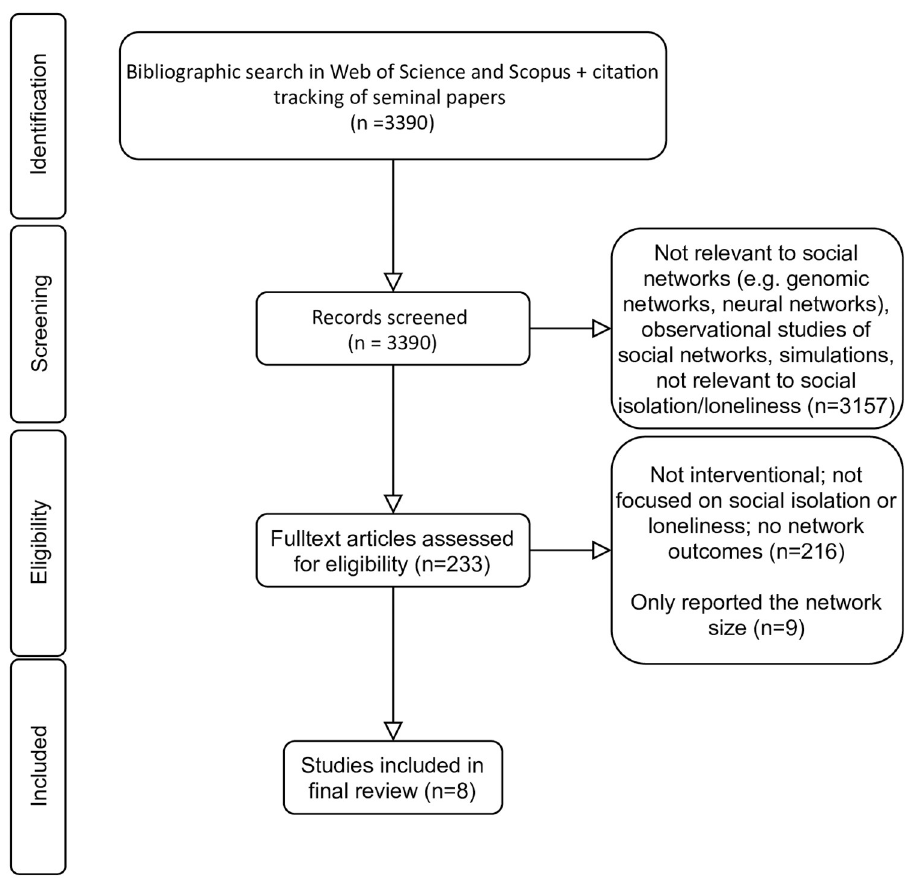
Fig 1. PRISMA flow diagram of the study